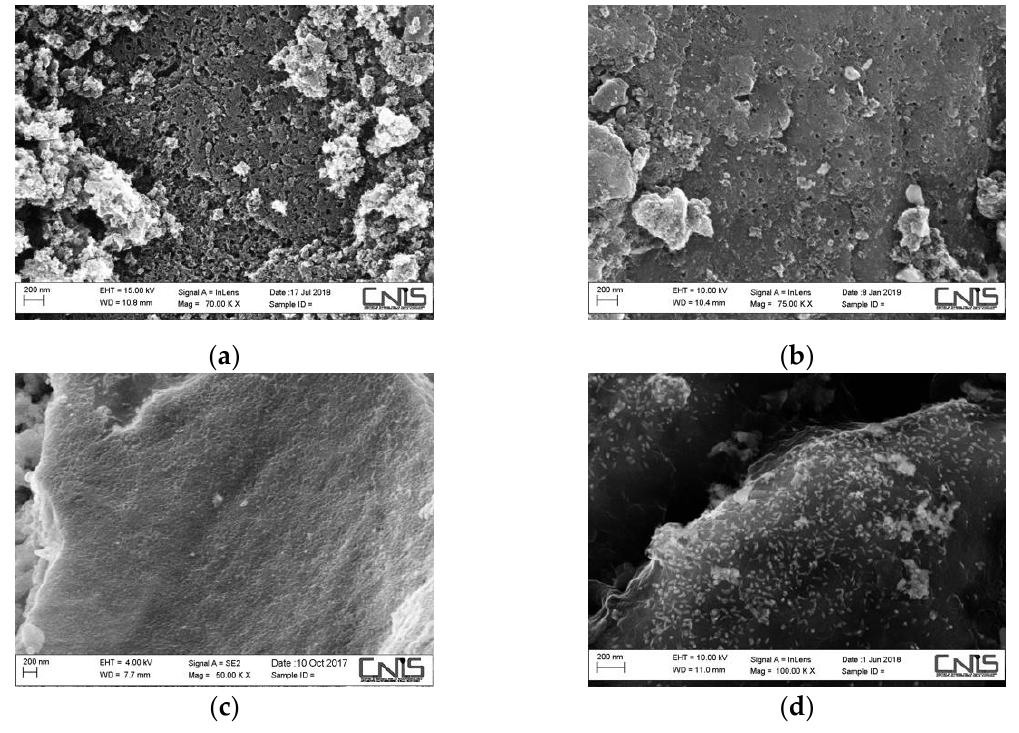
Figure 3. SEM images at 200 nm of resolution: ( a ) commercial Activated Carbon; ( b ) PWBC; ( c ) RHBC and ( d ) EuFeBC. Other images can be found in Supplementary Materials (Images S1 and S2).